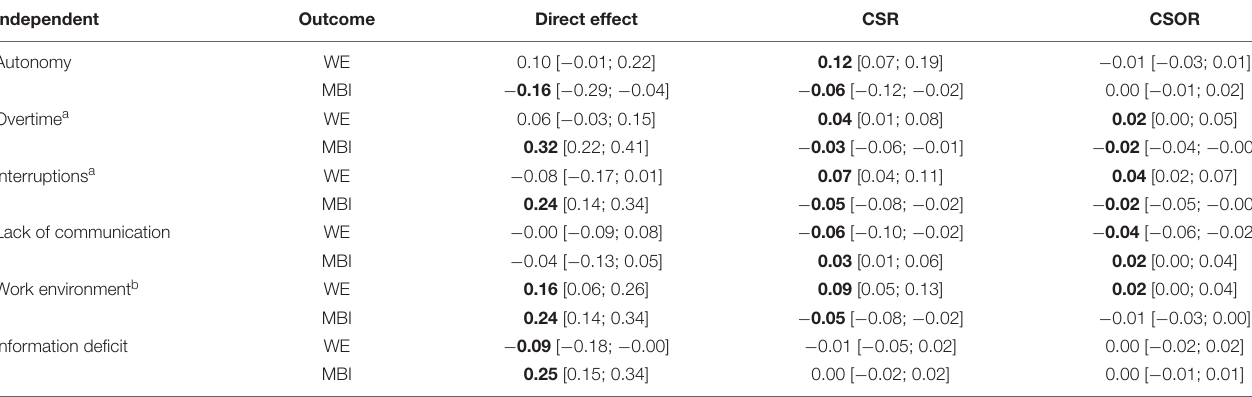
TABLE 5 | Direct and indirect effects of job characteristics on work engagement (WE) and emotional exhaustion (MBI) via job crafting structural (CSR) and social resources (CSOR).